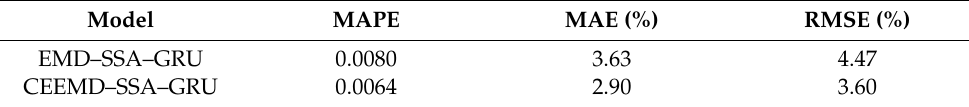
Table 5. Prediction error evaluation index.